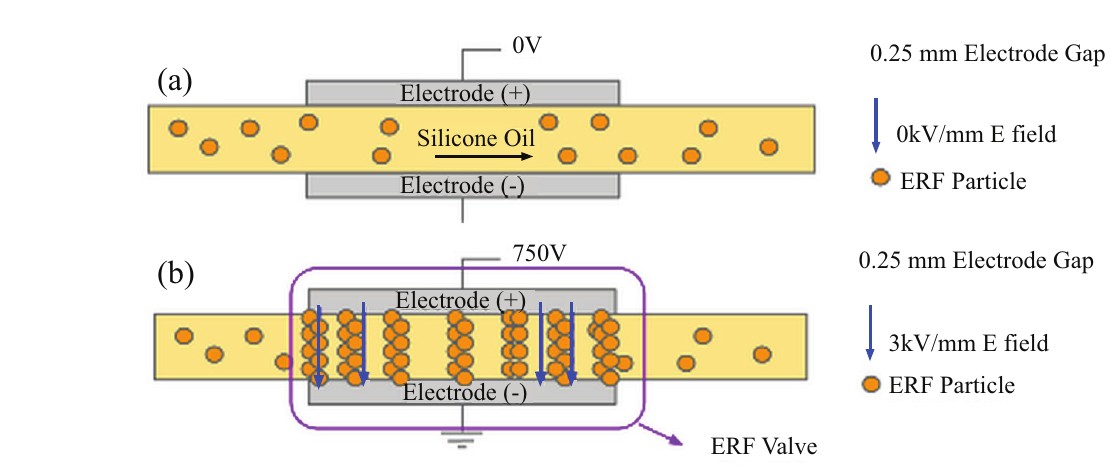
Figure 1. Electrorheological fluid (ERF) flows between two electrode plates. ( a ) The configuration has no potential across the electrodes, while ( b ) the configuration has 750 V of voltage potential across a 0.25-mm gap, which is an electric field (E-field) of 3